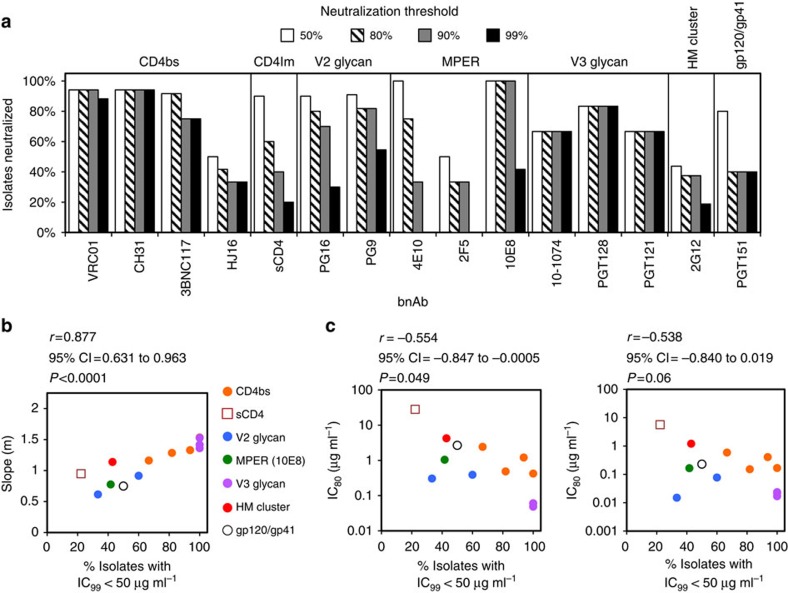
Effect of slope on neutralization breadth.(a) Neutralization breadths determined from dose–response curves of each bnAb against our total Env panel at increasing neutralization thresholds. A bnAb is considered non-neutralizing for a particular Env at a given inhibitory threshold when the respective inhibitory concentration (IC50, IC80, IC90 or IC99) is >50 μg ml−1. Antibodies are ordered by epitope class. Correlations of slope (b), IC80 (c, left) and IC50 (c, right) to breadth at 99% neutralization for each bnAb, grouped by epitope class (symbols), where breadth excludes Envs giving no detectible neutralization within the parameters of our assay (Methods). Pearson correlations (r), 95% CI and associated P values are indicated above each graph.